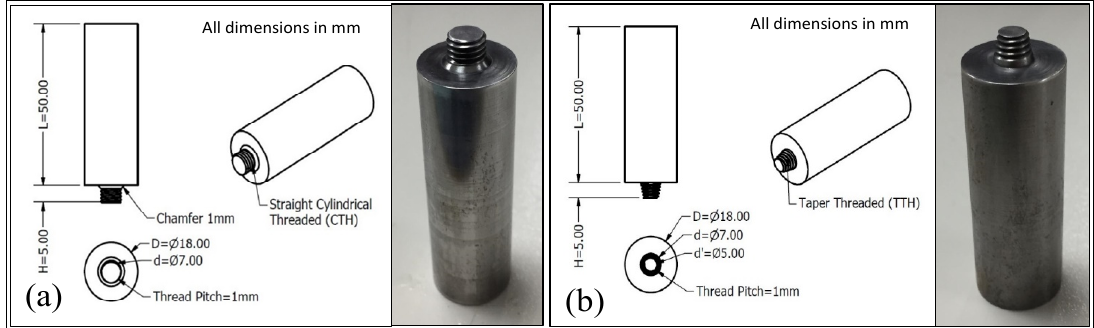
Figure 2. Schematic diagram of FSP Tools, ( a ) Straight Cylindrical Threaded (CTH) and ( b ) Taper Threaded (TTH).